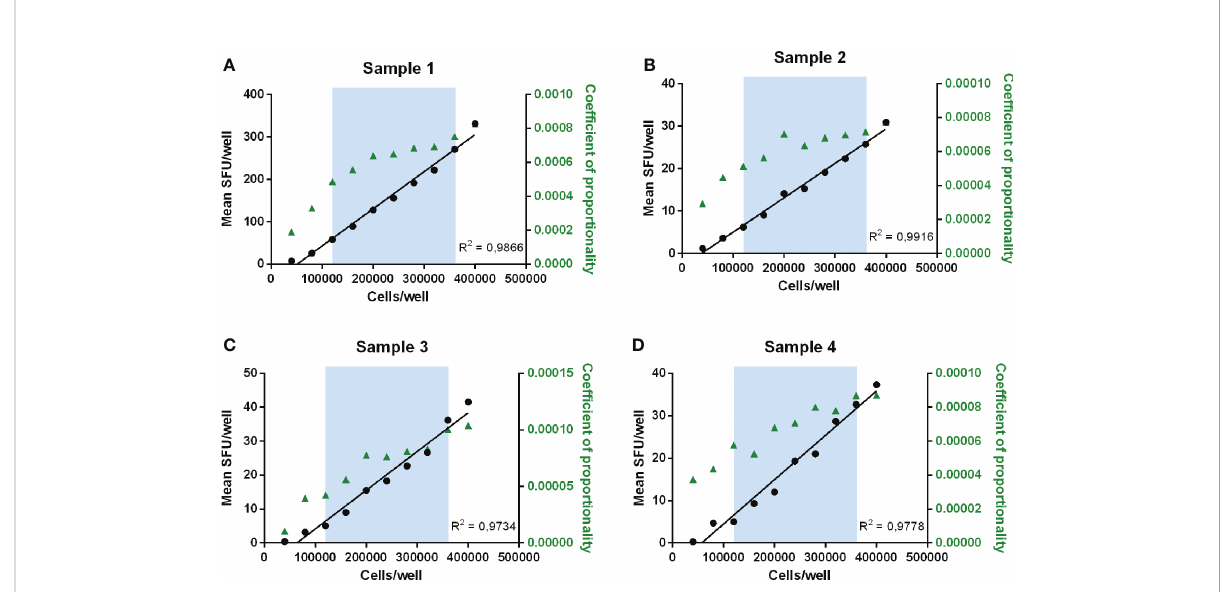
FIGURE 4 Determination of linearity and proportionality. Mean SFU/well is plotted against the number of cells plated per well for each sample (A – D) . The blue zone indicates the range between 120 000 and 360 000 cells/well where recovery values ranged between 50 and 150% and therefore linearity was demonstrated. Correlation curves of the number of plated cells per well and the mean responses (SFU/well) are shown in black with the concerned R2 values. The coef fi cients of proportionality, calculated as the ratios of the observed number of spots per well versus the number of plated cells, are indicated in green triangles and represented on the right